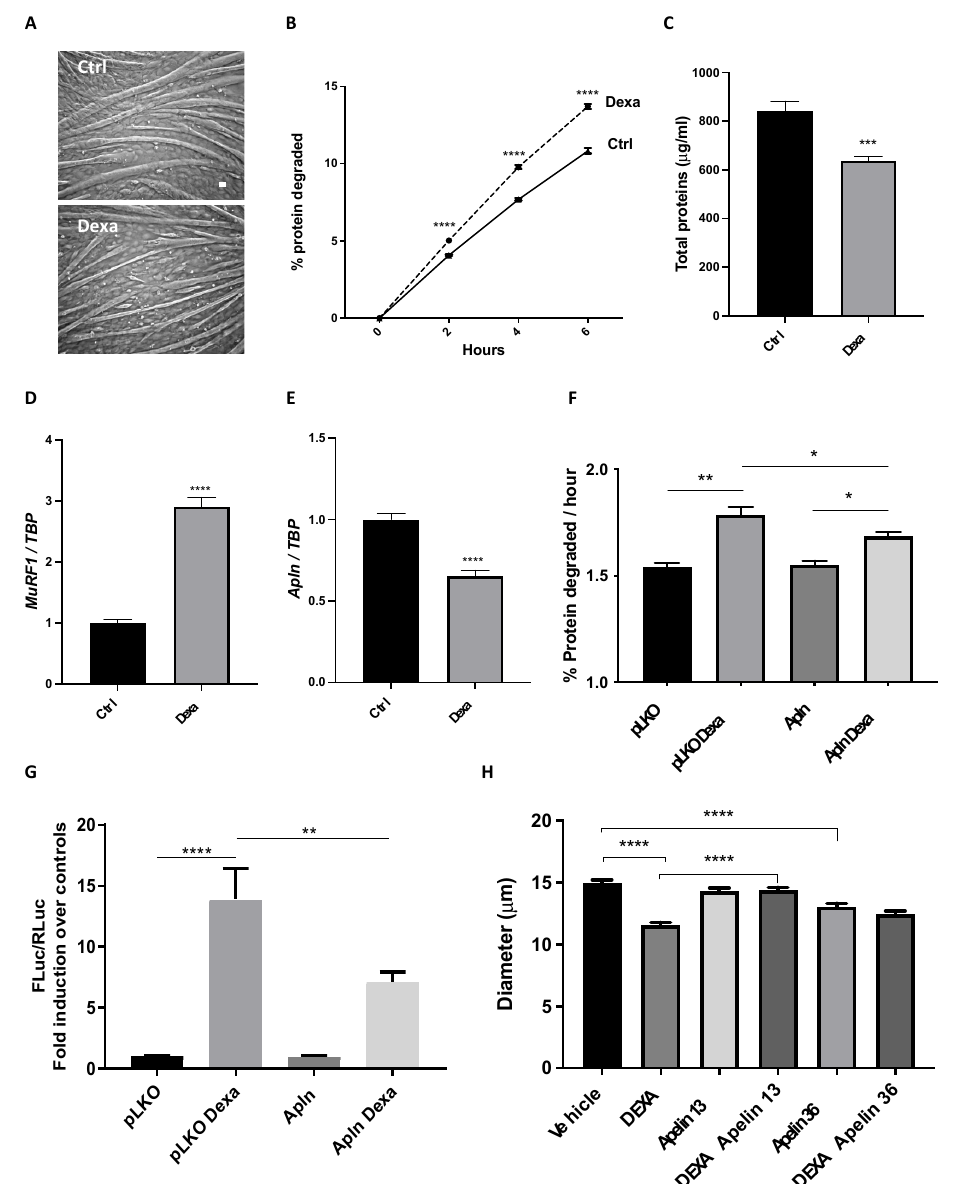
Figure 3. Apelin protects myotubes from dexamethasone-induced atrophy. Four day-differentiated myotubes were exposed for 24 h to vehicle (Ctrl) or 10 μ M dexamethasone (Dexa) and representative brightfield images are shown. Scale bar, 15 μ m ( A ). In radioactive-based assays, we measured long-lived protein degradation of myotubes treated with vehicle or 10 μ M Dexa for 36 h; it was induced by 25% by Dexa ( B ). Multiple t -tests, **** p ≤ 0.0001, n = 6. Dexa-treated myotubes have lower total protein content than controls (Ctrl) ( C ). Unpaired t -test, *** p ≤ 0.001, n = 6. Like in vivo, Q-PCR shows that MuRF1 expression is induced ( D ), while apelin expression is reduced ( E ) in myotubes treated for 24 h with 10 μ M Dexa. TBP was used as housekeeping gene. Unpaired t -test, **** p ≤ 0.0001, n = 6. Four day-differentiated myotubes transfected with the empty vector pLKO, as control, or preproapelin-encoding plasmid for 24 h were treated with 10 μ M Dexa for 24 h. Exogenous preproapelin partially restrained the Dexa-induced degradation of long-lived proteins ( F ). Ordinary one-way ANOVA, * p ≤ 0.05, n = 6, ** p ≤ 0.01. Myoblasts were transfected with a plasmid in which Firefly luciferase (FLuc) is under the control of a MuRF1 promoter, with another for Renilla luciferase (RLuc), under the control of thymidine kinase promoter to normalize the data (ratio 50:1) and with the empty vector pLKO, as control, or a preproapelin-expressing plasmid (Apln). After 24 h, myoblasts were treated with vehicle or with 10 μ M Dexa for 24 h. Dexa-induced MuRF1 expression was reduced in myoblasts that express exogenous preproapelin ( G ). Ordinary one-way ANOVA, ** p ≤ 0.01, **** p ≤ 0.0001, n = 12. Unlike apelin 36, apelin 13 fully protects myotubes from